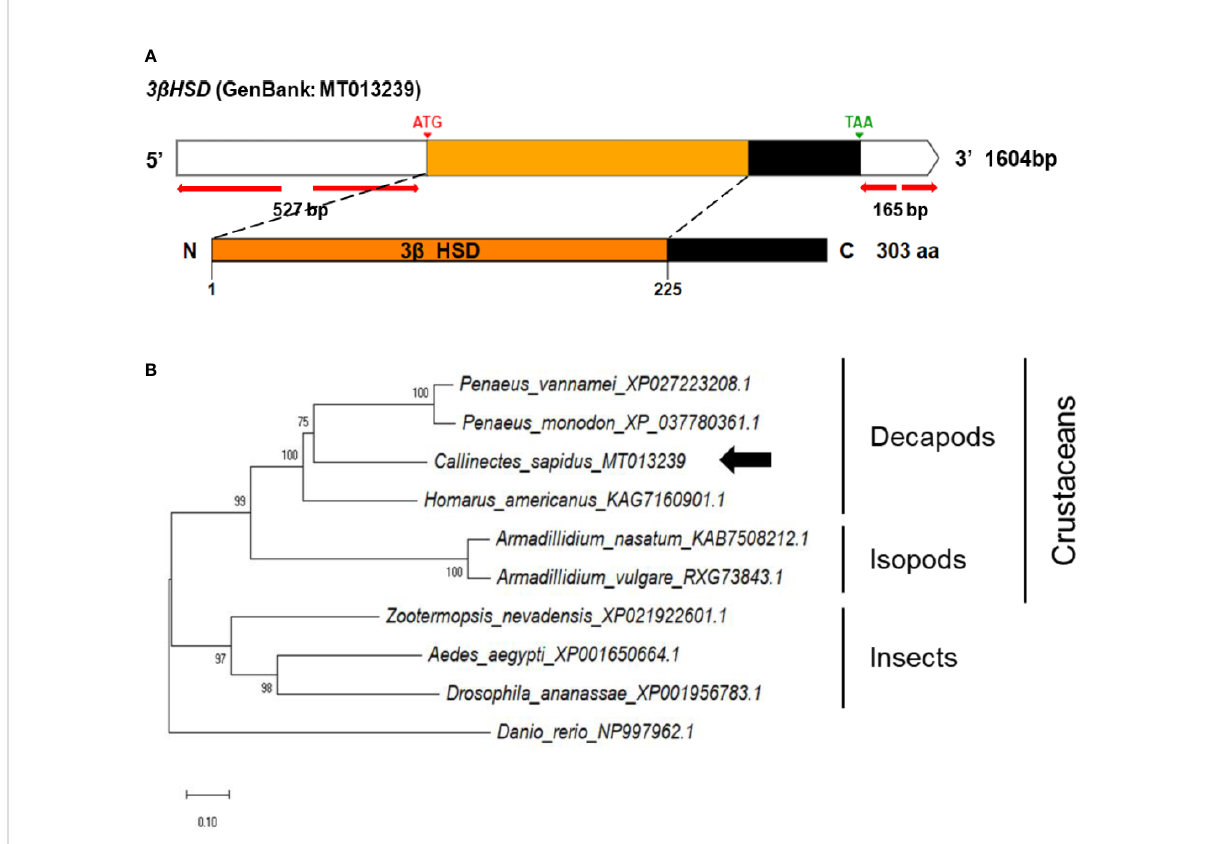
FIGURE 4 (A) Schematic representation of C. sapidus 3 b HSD . The conserved domain of 3 b HSD protein is marked in orange (3 b _HSD: 3-beta hydroxysteroid dehydrogenase/isomerase). (B) Phylogenetic tree of 3 b HSD was constructed using neighbor-joining (NJ) approach in MEGAX. The amino acid sequences of 3 b HSD of crustaceans, insects and zebra fi sh were retrieved from NCBI database. Bootstrap consisted of 1000